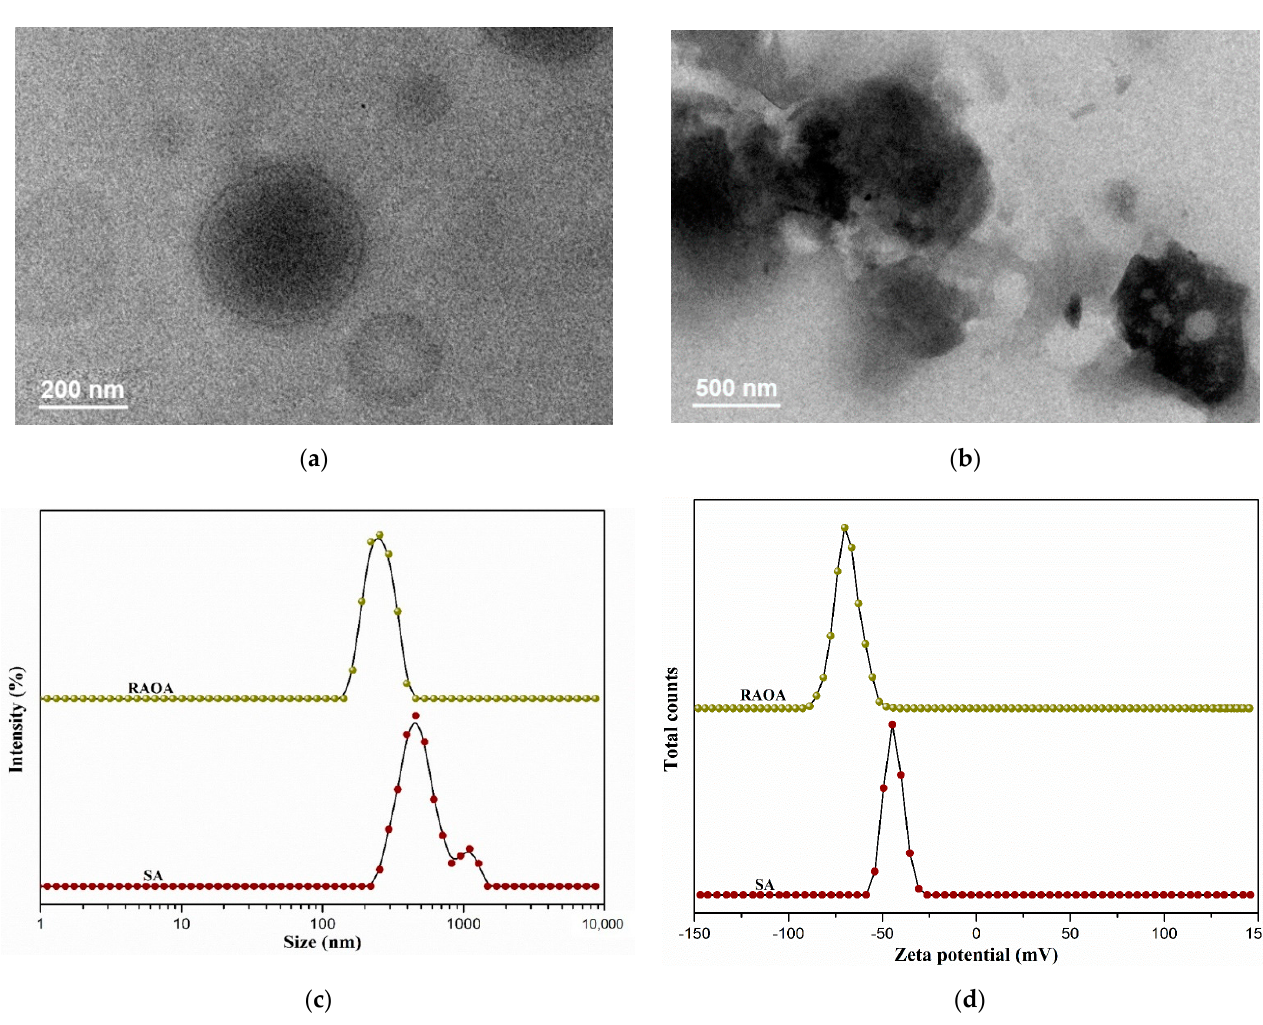
Figure 7. TEM image of ( a ) RAOA self ‐ assembled micelles and ( b ) SA self ‐ aggregates; ( c ) hydrodynamic diameter distribution and ( d ) zeta potential distribution of RAOA self ‐ assembled micelles and SA self ‐ aggregates.